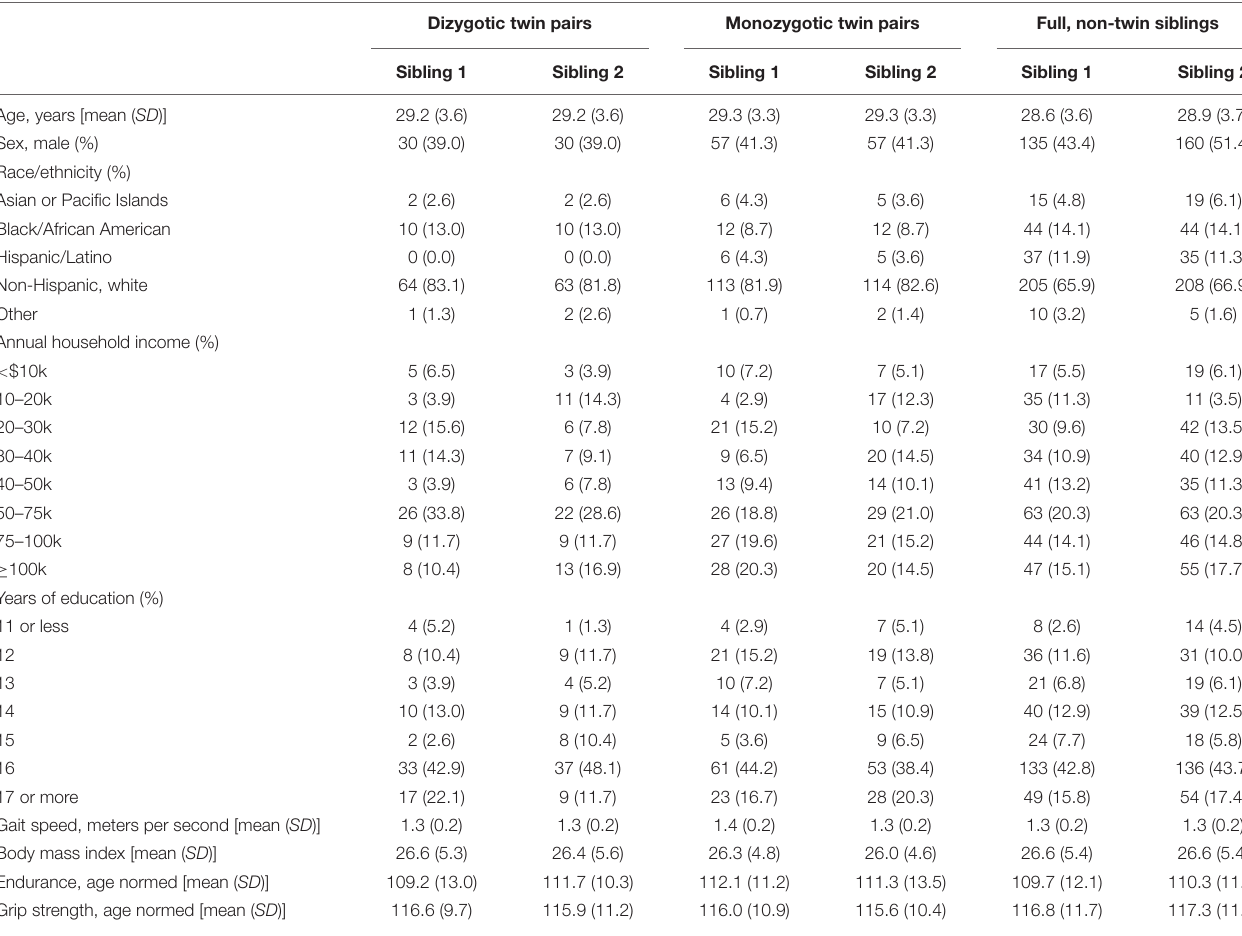
TABLE 5 | Descriptive information on each sibling pair